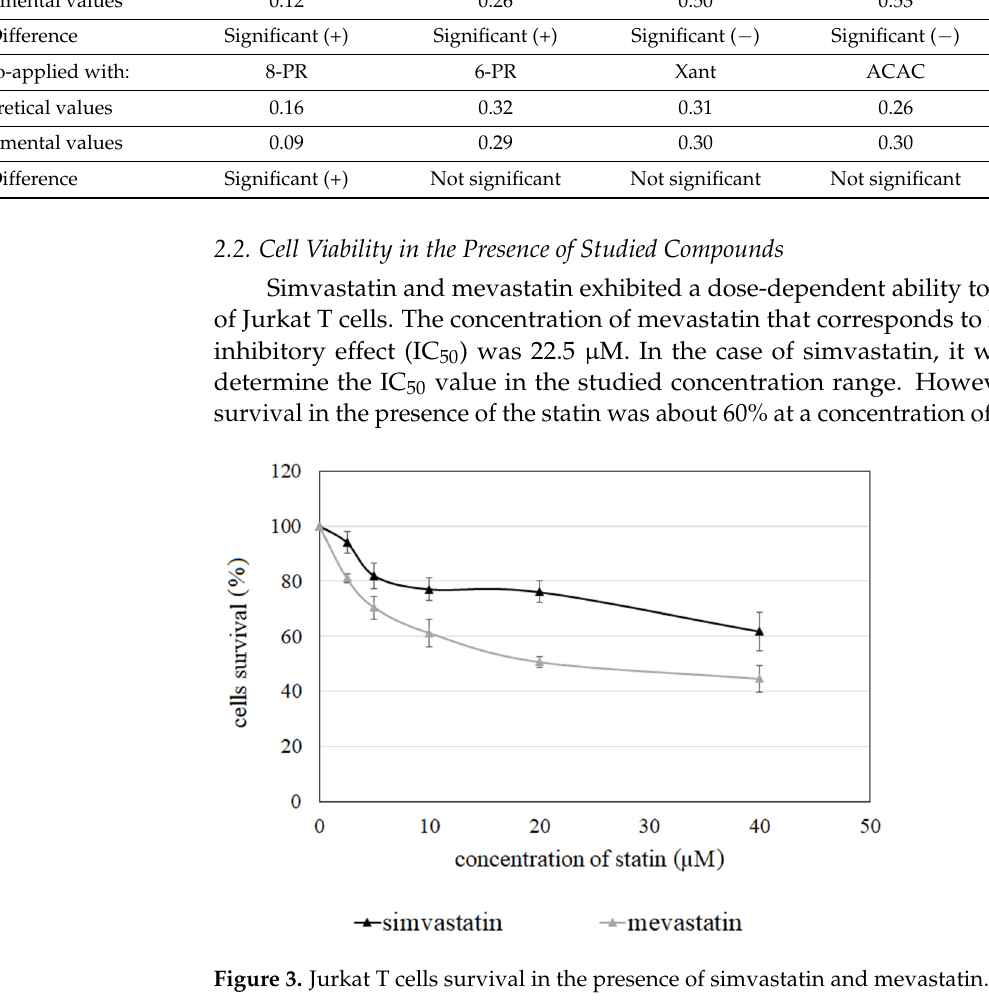
Figure 4. Representative profiles of growth inhibition for pure flavonoids 8-prenylnaringenin ( A ) or xanthohumol ( B ) and their combinations with simvastatin or mevastatin. 2.3. Apoptosis Induction Both studied statins induced the activity of caspase-3 ( p < 0,05); however, the potency of mevastatin was more significant than simvastatin (Figure 5A). In the case of single fla- vonoids, only acacetin (Figure 5B) and chrysin (Figure 5C) increased the activity of the studied enzyme. However, the combination use of acacetin and statins did not change the effect obtained for flavonoids only (Figure 5B). It is worth emphasizing that an increase in caspase-3 activity was noted with the simultaneous application of mevastatin with other